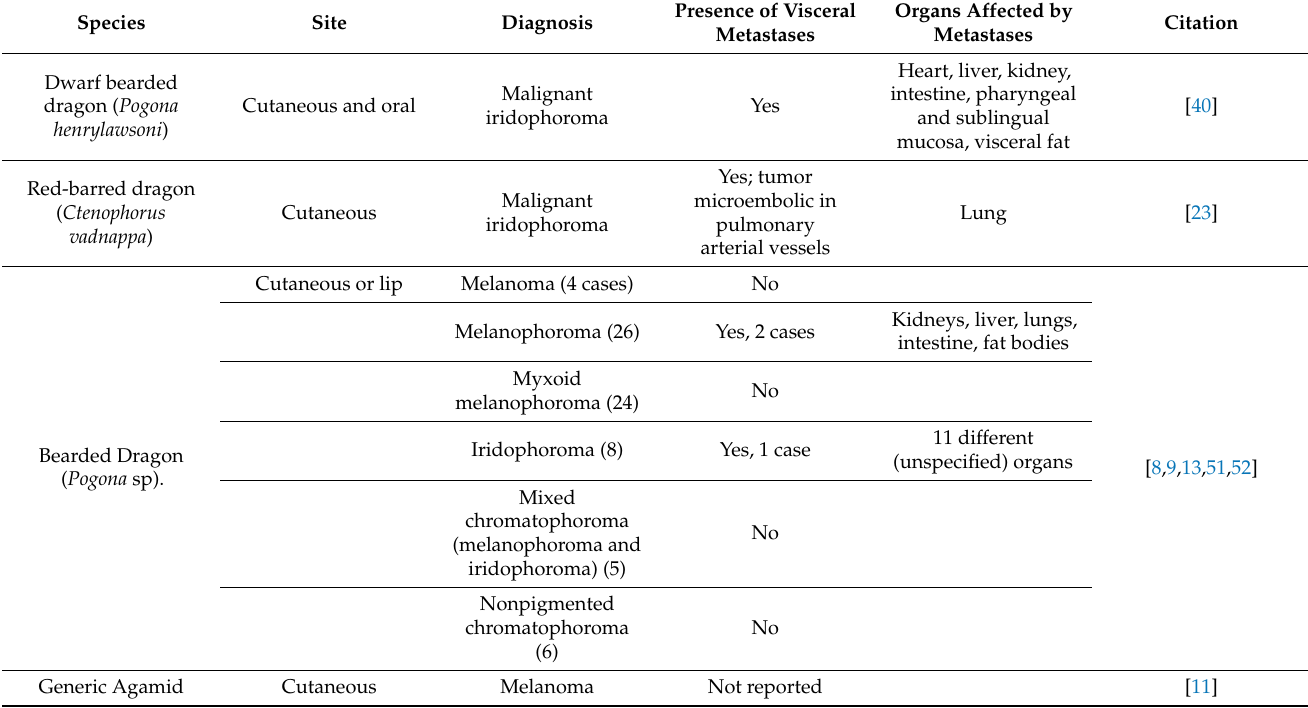
Table 1. Clinical features of chromatophoromas in the reptile family: Agamidae